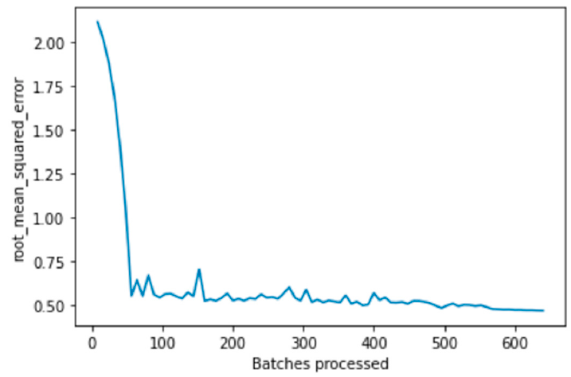
Figure 15. Observed training metric during training.